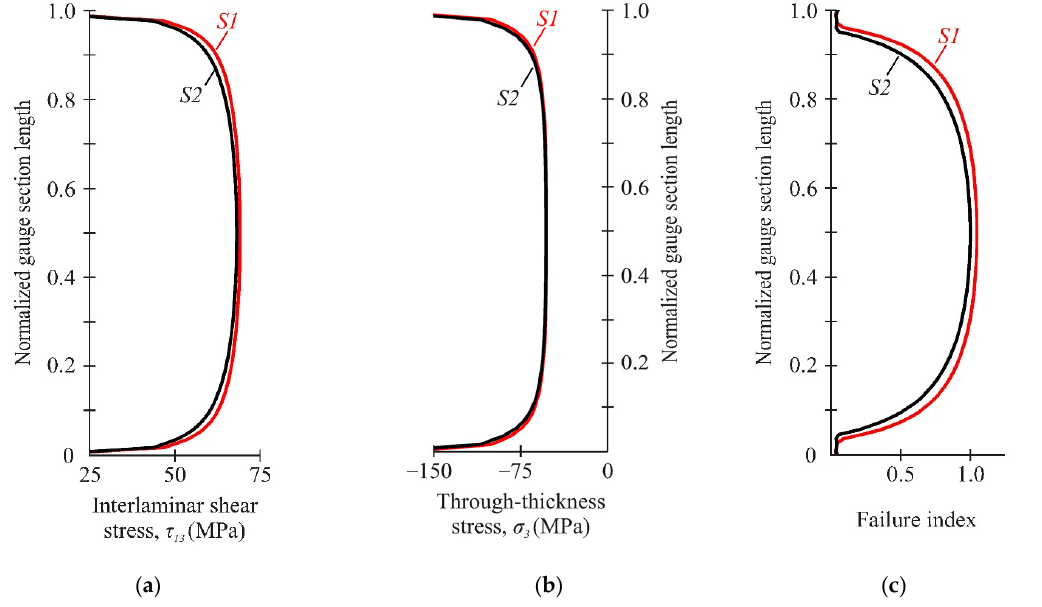
Figure 7. Distribution of interlaminar shear stresses ( a ), through-thickness stresses ( b ), and failure indexes NU-Daniel ( c ) between the notches on the face (S1) and the middle (S2) surfaces. A detailed stress analysis on the face surface of the specimen (S1) under different compression–shear loading was performed to determine the possible failure zone. An analysis of the stress fields at a loading angle α = 45° showed the localization of the maximum shear stresses in several areas (Figure 8a). The shear stress achieved 69 MPa in the gauge section of the specimen, while, near the notch flanks, the stress was approximately at the same level of 66 MPa. The maximum through-thickness compressive stresses were localized near the notch root and achieved 212 MPa (Figure 8b). Failure index maps